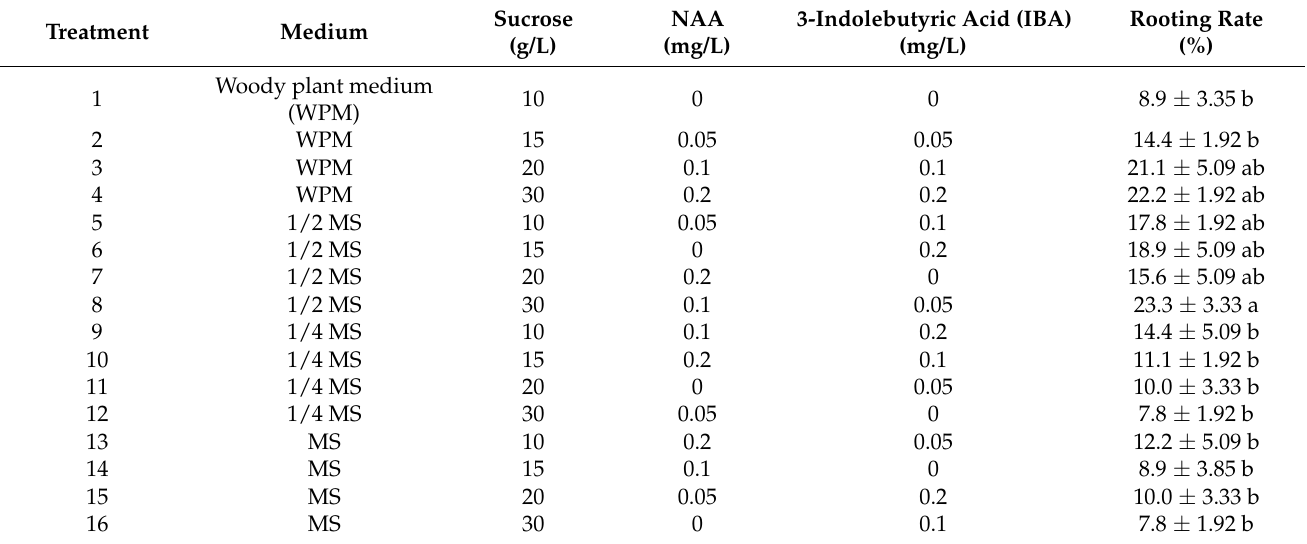
Table 4. Rooting rate of tissue-cultured peony microplants with different combinations of